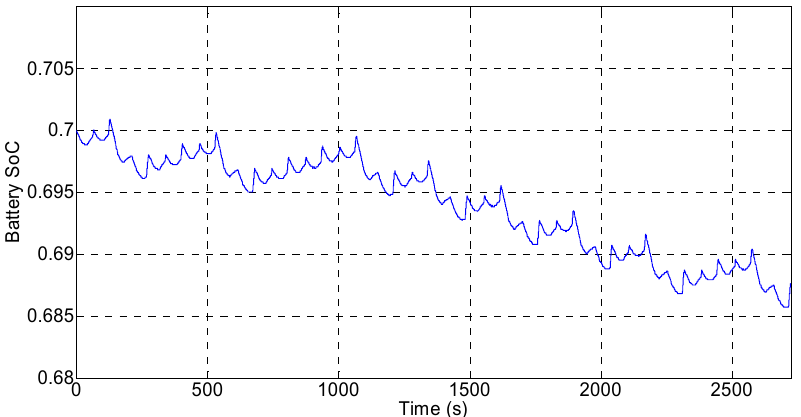
Figure 13. SoC of the lithium battery under continuous work conditions.